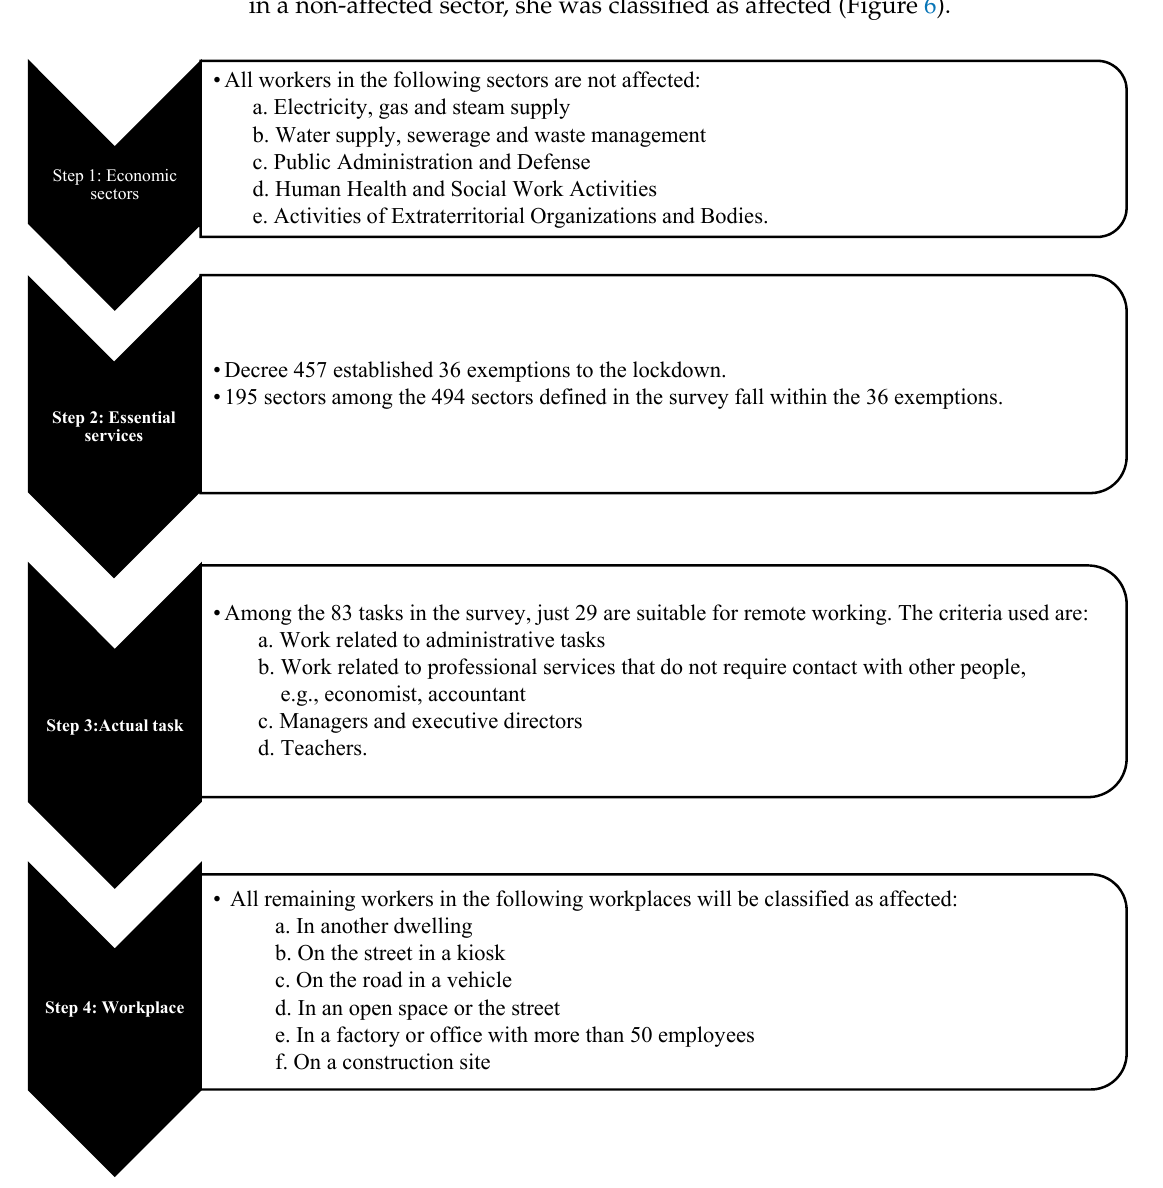
Figure 6. Steps to identify affected workers and their application to Colombia. Source: Authors calculations using Gran Encuesta Integrada de Hogares 2018 (Colombian Hosuehold Survey). Third, we used the results from the CGE macrosimulations to determine the employ- ment status and income levels of both affected and unaffected workers at the end of the year 2020. The pandemic was assumed to last through the entirety of 2020, so after the three months of the lockdown and the progressive reopening of the economy, workers would start recovering their jobs. At this point we used the predictions from the macroanalysis us- ing the CGE to determine the distribution of unemployment by sector and type of workers (defined by their age, qualification, and formal status). We randomized the workers in each sector and type that each month remained unemployed or exited unemployment to ensure that the numbers by end of 2020 were consistent with the CGE-generated